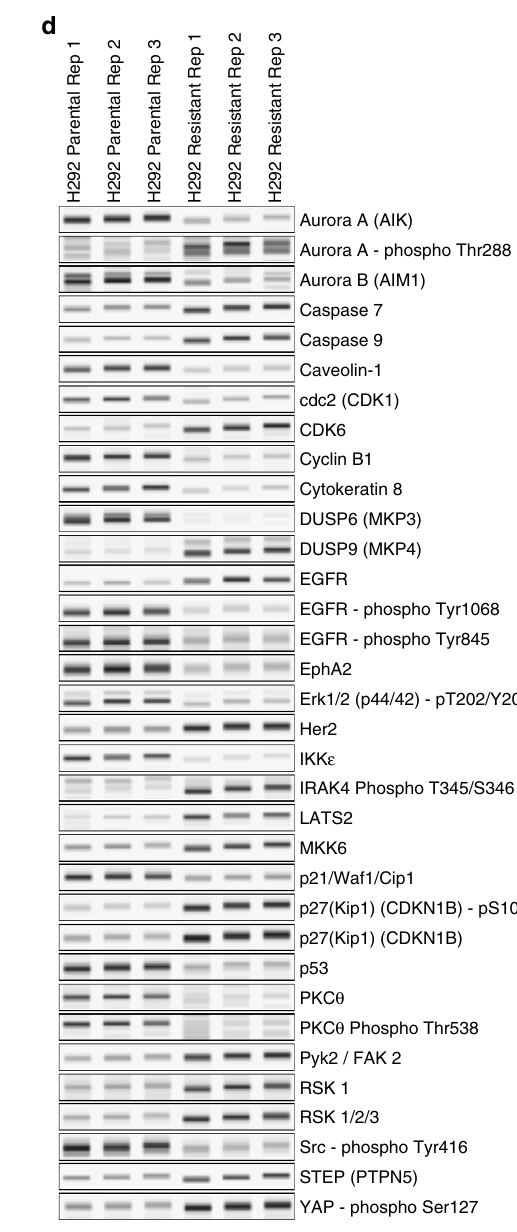
Figure 5 | DigiWest results. ( a ) Volcano plot of the Kinobead pull-down analysis. The data contained in this volcano plot are based on quantified signals obtained from an equivalent to about 1,000 western blot lanes. Samples were performed in triplicate. A total of 185 analytes were detected, including 74 phosphorylations. Log2 fold change of the Lapatinib-resistant H292 cell line compared with the parental cell line. P values are from t -tests with Welch approximations. ( b ) The same analysis as in a , but for whole-cell lysates. ( c ) Detail of the Ingenuity pathway analysis indicating p53 as the central regulator. ( d ) Whole-cell lysate analysis. Digital reconstruction of western blots (greyscale maps) from the DigiWest data representing the 34 most significantly changed analytes in alphabetical